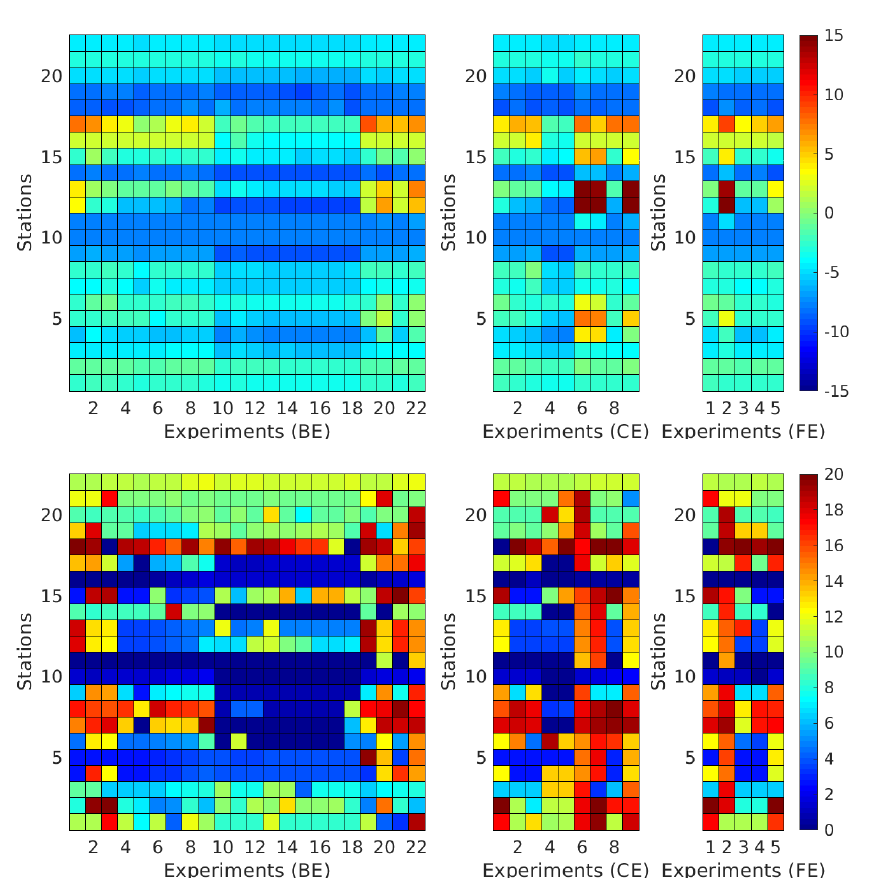
Figure 5. Upper panel—the difference between model results after 20 min simulation and obser- vations; bottom panel—the time of the maximum wave height of all experiments at observation stations (Figure 2). Left —basic experiments (BE); middle —correction experiments (CE); right —final experiments